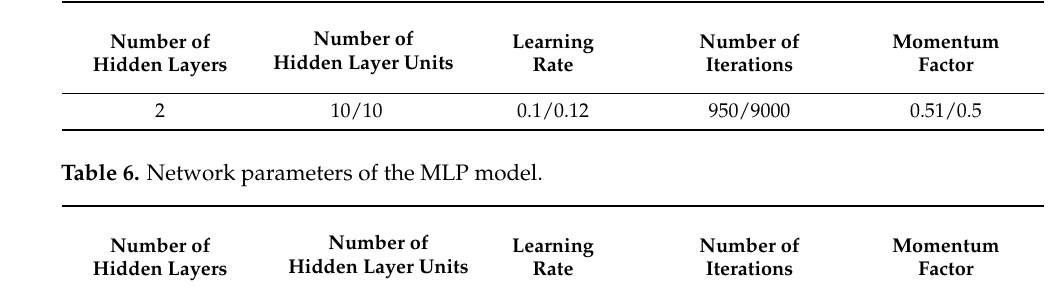
Table 5. Network parameters of the SAE model.